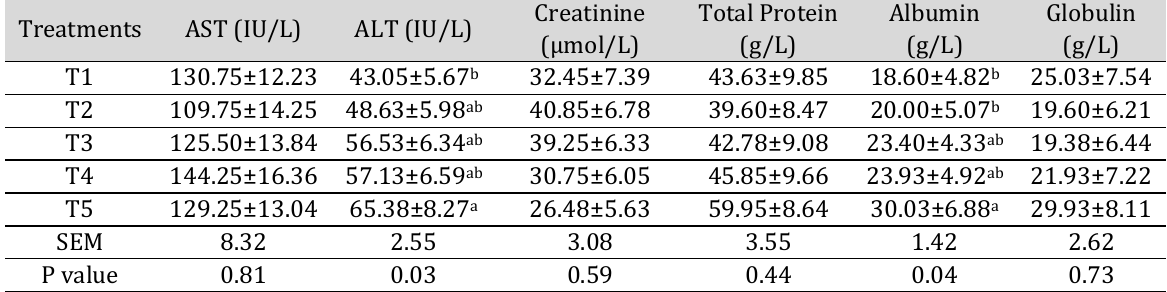
Table 4. Effects of different seed powder supplements on the serum biochemical parameters at six weeks.